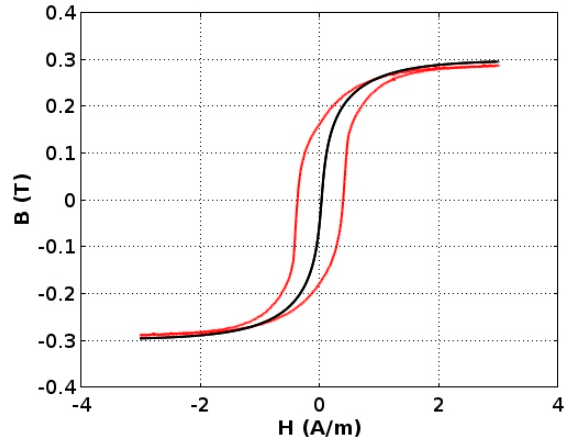
Figure 6. An anhysteretic magnetization curve (black line) is determined in Step 1 on the base of major hysteresis loop measurement results (red line).